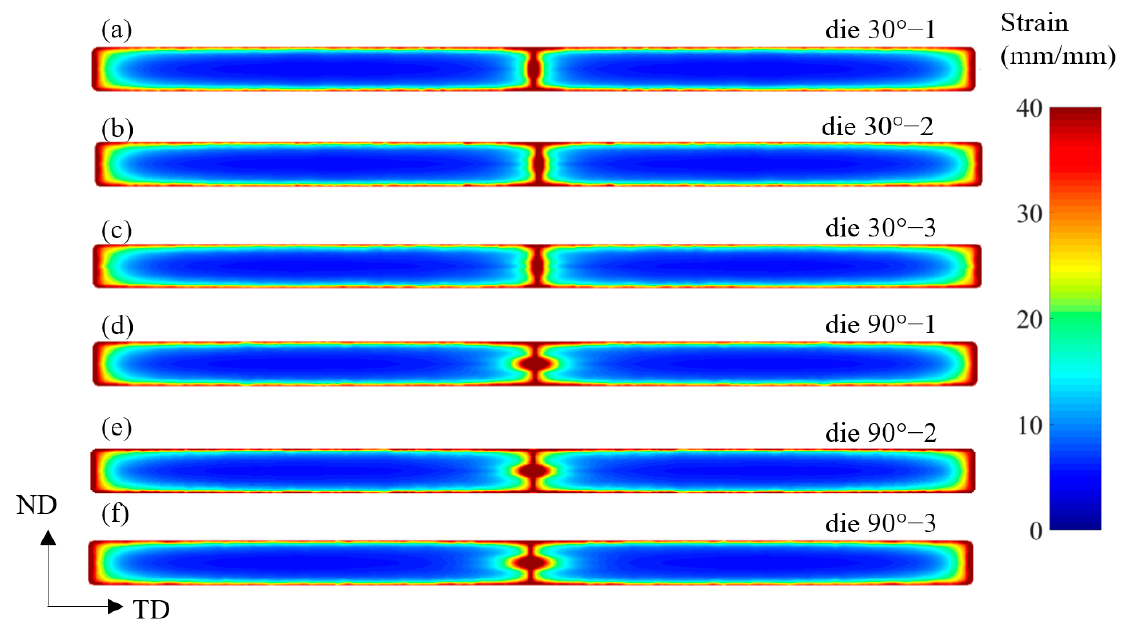
Figure 19. Strain distribution at the die exit of the profiles extruded using bridges with different upper bridge’s geometries. ( a ) die 30° − 1, ( b ) die 30° − 2, ( c ) die 30° − 3, ( d ) die 90° − 1. ( e ) die 90° − 2 and ( f ) die 90° − 3.